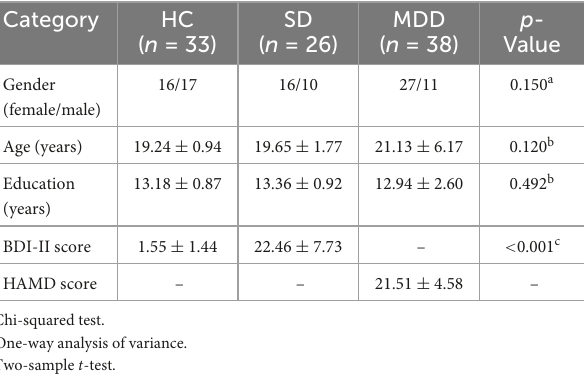
TABLE 1 Demographic and clinical